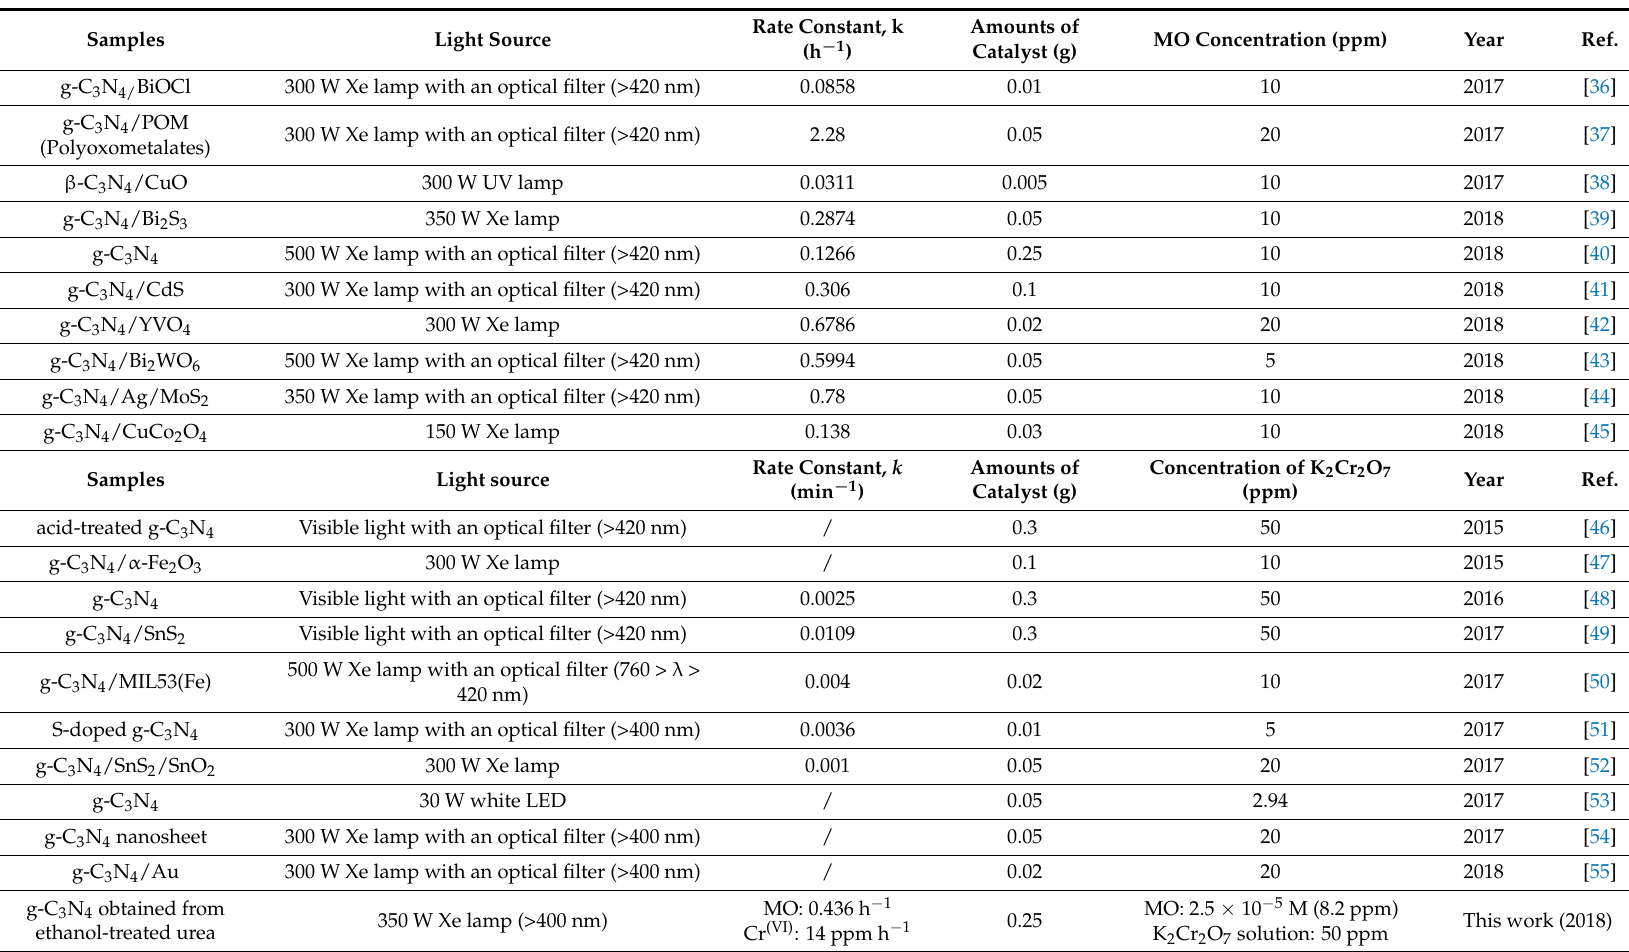
Table 2. Reported reaction conditions, including light source, original concentration of MO or Cr (VI) solution, and photocatalytic performance using various polymeric g-C 3 N 4